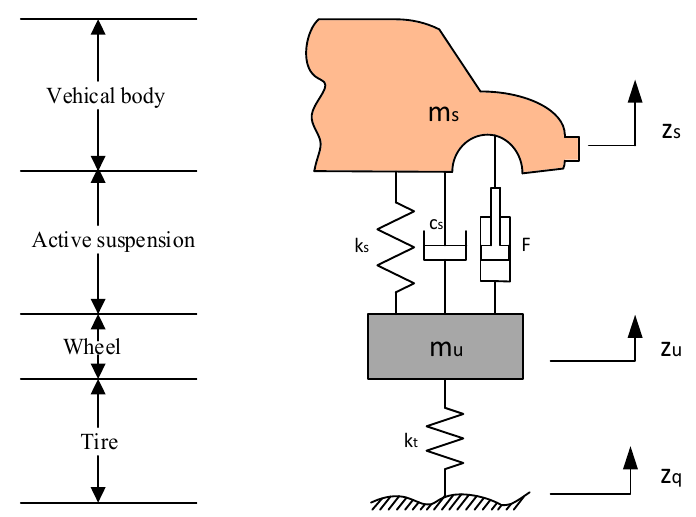
Figure 2. Mechanical model of a quarter car active suspension system.